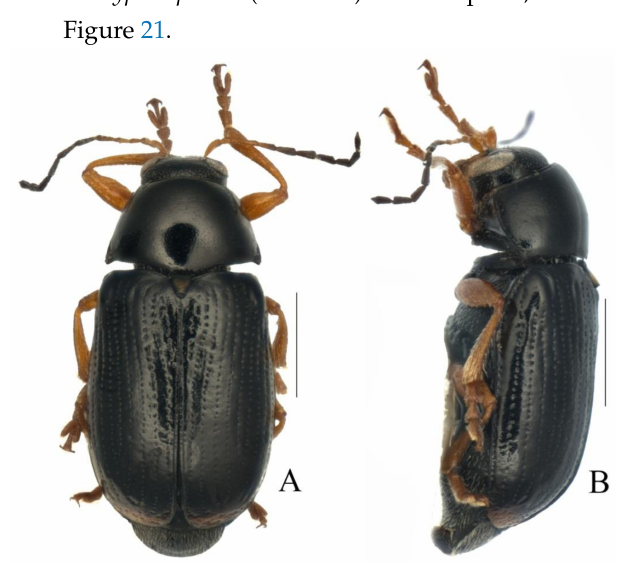
Figure 21. Cryptocephalus ( Burlinius ) kabaki Lopatin, 2002: ( A ). habitus; ( B ). lateral view of habitus (Scale bars: 0.5 mm) (holotype,